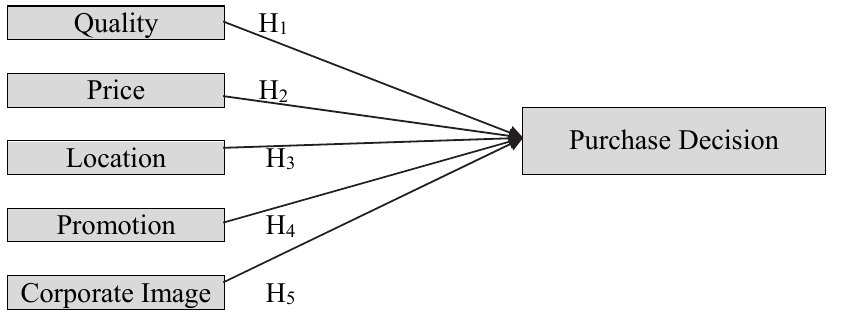
Fig. 1. Conceptual